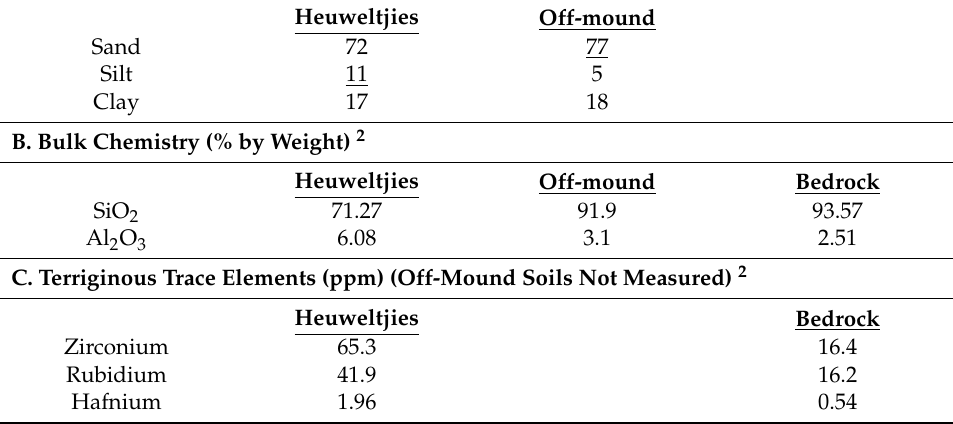
Table 1. Soil texture and geochemistry data from soils of heuweltjies, off-mound areas, and bedrock at the Clanwilliam